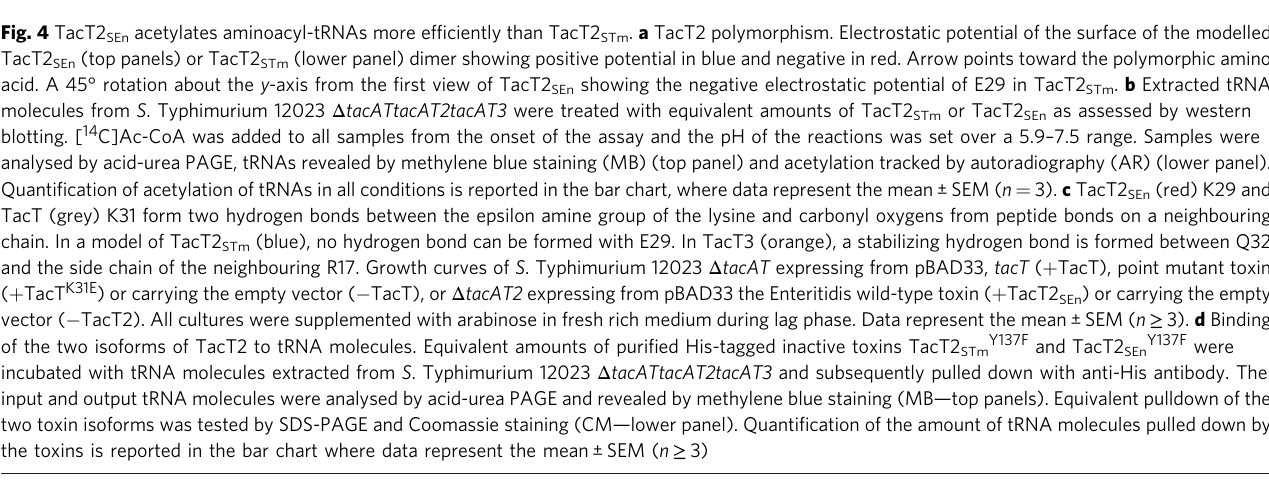
Fig. 4 TacT2 SEn acetylates aminoacyl-tRNAs more ef fi ciently than TacT2 STm . a TacT2 polymorphism. Electrostatic potential of the surface of the modelled TacT2 SEn (top panels) or TacT2 STm (lower panel) dimer showing positive potential in blue and negative in red. Arrow points toward the polymorphic amino acid. A 45° rotation about the y -axis from the fi rst view of TacT2 SEn showing the negative electrostatic potential of E29 in TacT2 STm . b Extracted tRNA molecules from S . Typhimurium 12023 Δ tacATtacAT2tacAT3 were treated with equivalent amounts of TacT2 STm or TacT2 SEn as assessed by western blotting. [ 14 C]Ac-CoA was added to all samples from the onset of the assay and the pH of the reactions was set over a 5.9 – 7.5 range. Samples were analysed by acid-urea PAGE, tRNAs revealed by methylene blue staining (MB) (top panel) and acetylation tracked by autoradiography (AR) (lower panel). Quanti fi cation of acetylation of tRNAs in all conditions is reported in the bar chart, where data represent the mean ± SEM ( n = 3). c TacT2 SEn (red) K29 and TacT (grey) K31 form two hydrogen bonds between the epsilon amine group of the lysine and carbonyl oxygens from peptide bonds on a neighbouring chain. In a model of TacT2 STm (blue), no hydrogen bond can be formed with E29. In TacT3 (orange), a stabilizing hydrogen bond is formed between Q32 and the side chain of the neighbouring R17. Growth curves of S . Typhimurium 12023 Δ tacAT expressing from pBAD33, tacT ( + TacT), point mutant toxin ( + TacT K31E ) or carrying the empty vector ( − TacT), or Δ tacAT2 expressing from pBAD33 the Enteritidis wild-type toxin ( + TacT2 SEn ) or carrying the empty vector ( − TacT2). All cultures were supplemented with arabinose in fresh rich medium during lag phase. Data represent the mean ± SEM ( n ≥ 3). d Binding of the two isoforms of TacT2 to tRNA molecules. Equivalent amounts of puri fi ed His-tagged inactive toxins TacT2 STm Y137F and TacT2 SEn Y137F were incubated with tRNA molecules extracted from S . Typhimurium 12023 Δ tacATtacAT2tacAT3 and subsequently pulled down with anti-His antibody. The input and output tRNA molecules were analysed by acid-urea PAGE and revealed by methylene blue staining (MB — top panels). Equivalent pulldown of the two toxin isoforms was tested by SDS-PAGE and Coomassie staining (CM — lower panel). Quanti fi cation of the amount of tRNA molecules pulled down by the toxins is reported in the bar chart where data represent the mean ± SEM ( n ≥